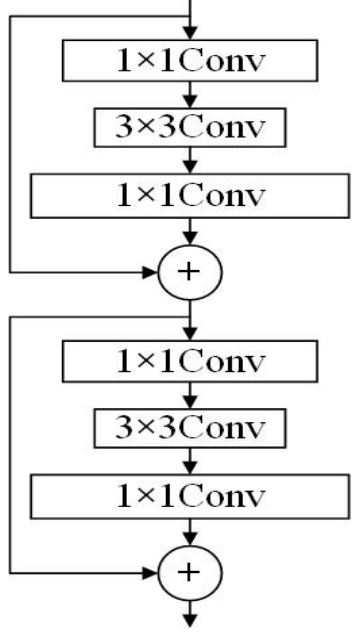
Figure 3. Pyramidal Residual Block.